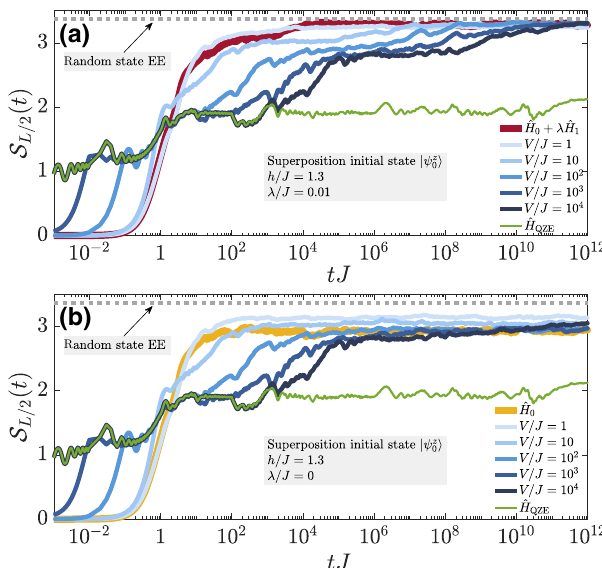
FIG. 6. Quench dynamics of the midchain von Neumann entanglement entropy under ˆ H = ˆ H 0 + λ ˆ H 1 + V ˆ H W , where λ ˆ H 1 is given by Eq. (3), (a) in the presence of errors at 0.01 J and (b) without errors, λ = 0. (a) Without protection, the error leads to the entanglement entropy growing to its